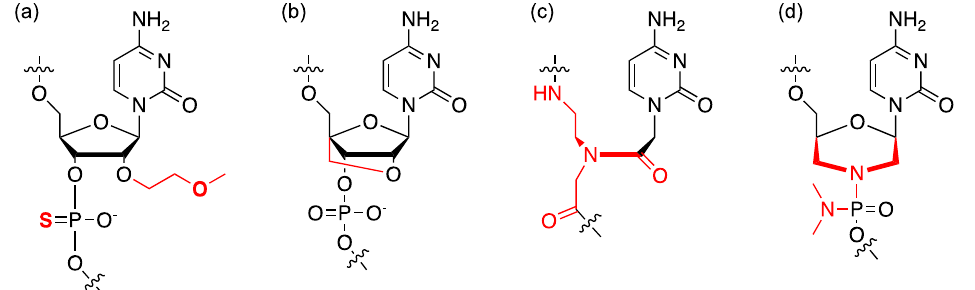
Figure 12. Chemical modifications of ASOs: ( a ) phosphorothioate and 2 ′ - O -methoxyethyl (MOE), ( b ) locked nucleic acid (LNA), ( c ) peptide nucleic acid (PNA), and ( d ) phosphorodiamidate morpholino oligomer (PMO). Red = modifications to the native DNA or RNA structure.